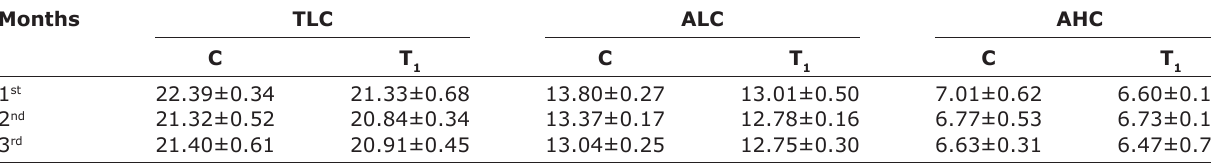
Table-5: Effect of CPF (mean±SE) on various leukocytic counts (10 3 /µl) in chicks. Months